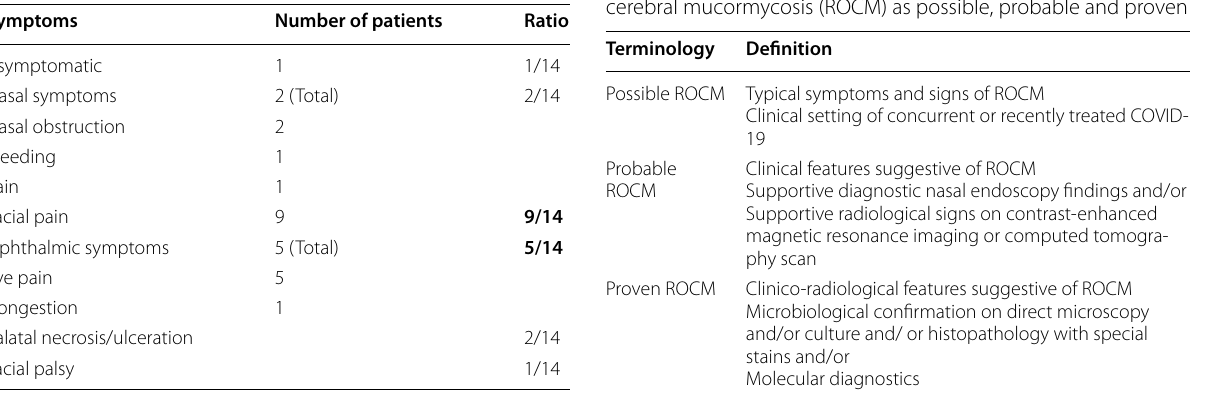
(Modified from Honavar SG. Code Mucor: Guidelines for the Diagnosis, Staging and Management of Rhino-Orbito-Cerebral Mucormycosis in the Setting